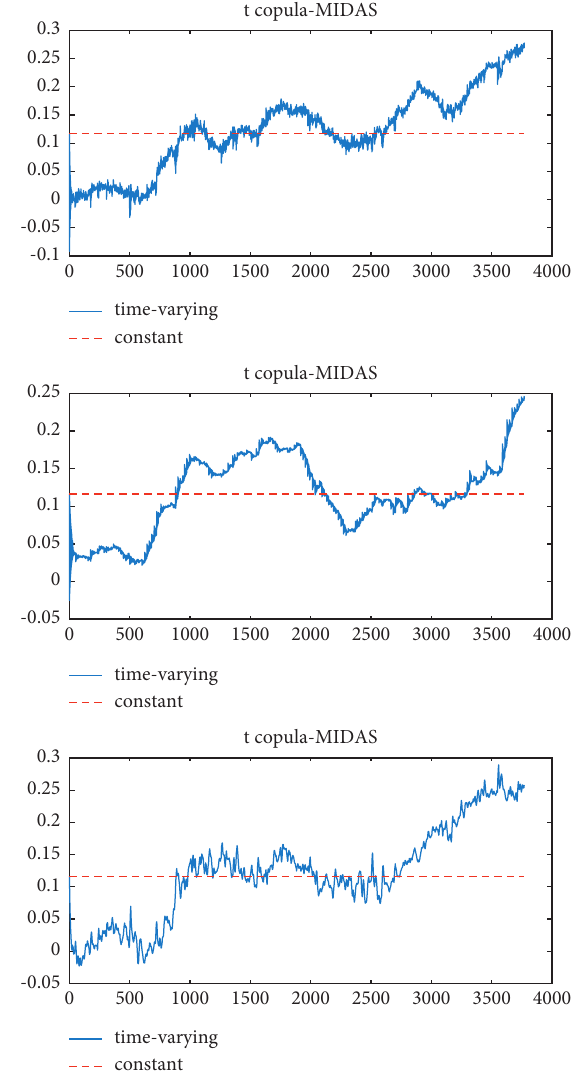
Figure 6: Estimated tail dependences from Student- t Copula- MIDAS model with GEPU, AEPU, and